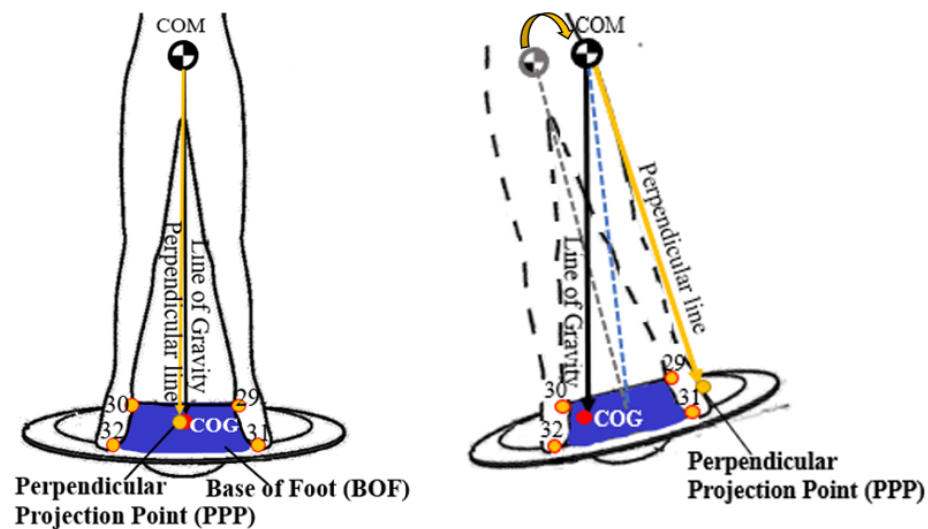
Figure 3. An illustration of the human body on the wobble board with necessary parameters: perpendicular-projection point (PPP), the base of foot (BOF), the center of gravity (COG), the line of gravity, and the perpendicular line under the stable ( left side ) and unstable ( right side ) balance